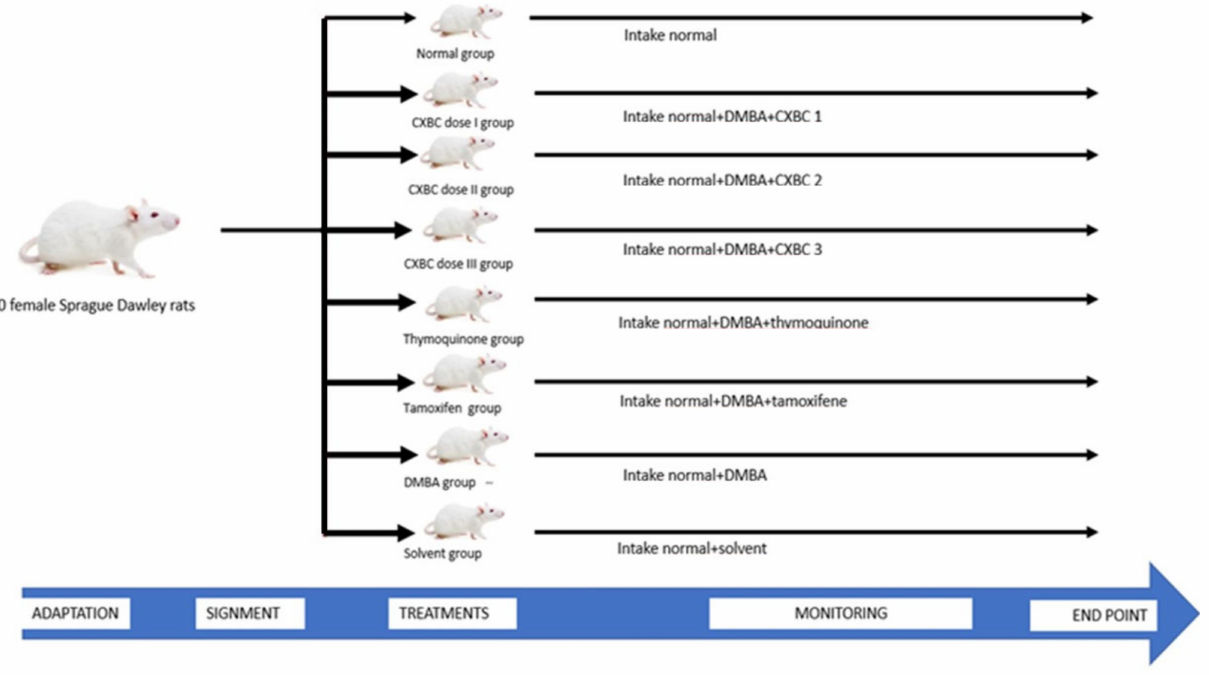
Figure 1. Placement and treatment of test